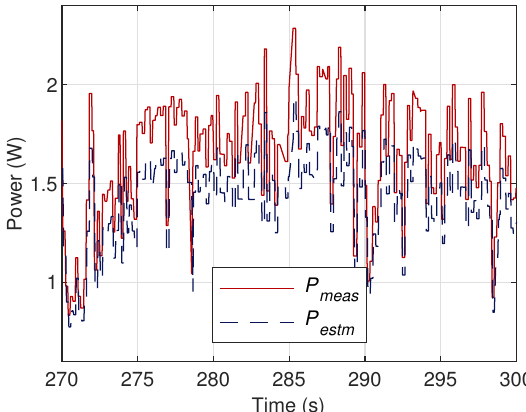
Figure 16. Measured power values drawn against estimated ones during the faulty power scenario experiment.